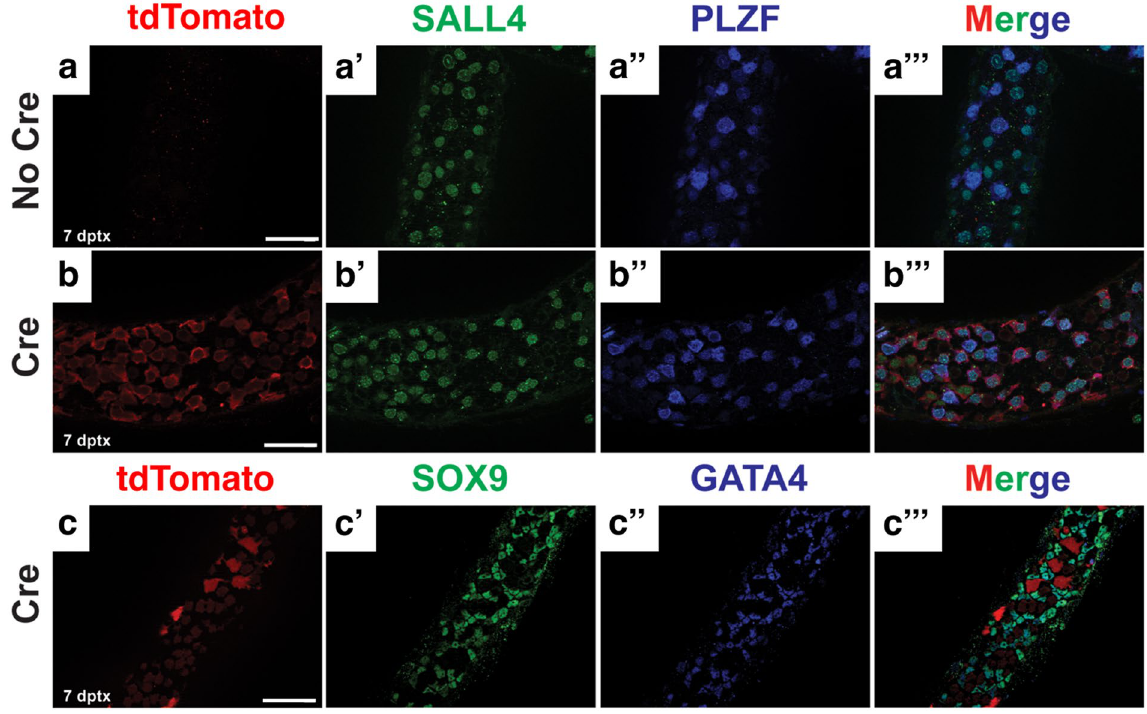
Figure 7. Sall4 GCE is active in undifferentiated spermatogonia. Immunofluorescence of wholemount seminiferous tubules. ( a –a’”) Rosa26-tdTomato and ( b –b’”, c –c’”) Sall4 GCE; R26-tdTomato testis 7 days post- tamoxifen treatment stained for tdTomato (red), SALL4 (green), SOX9 (green), PLZF (blue), GATA4 (blue). Scale bars in panels a,b,c: 100 µ m. All panels are in the same